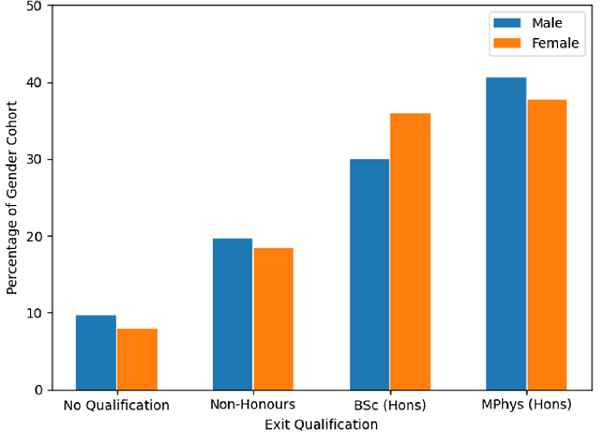
FIG. 1. Percentage of cohort exiting with each qualification type, disaggregated by gender ( N ¼ 444 , Male ¼ 330 , Female ¼ 114 ). CertHE, DipHE, and BSc (Ord) have all been grouped as “ non-honor ’ s ” due to low numbers.